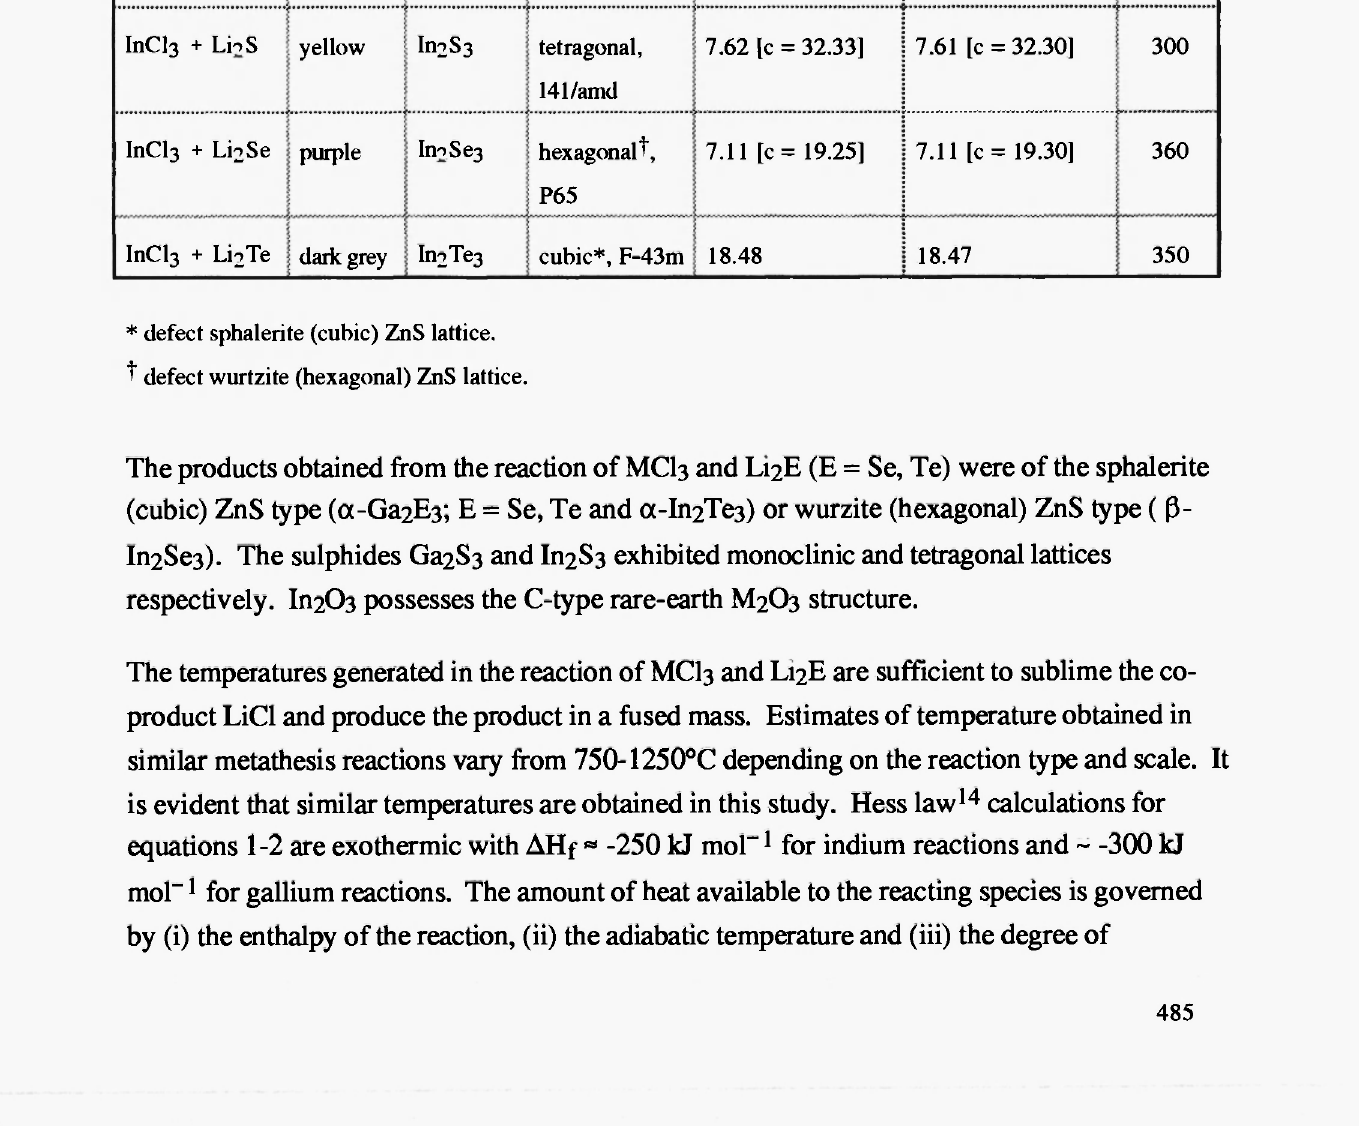
Table., 1. X-ray powder diffraction data from the reaction of MCI3 and L12E. Reagents colour X- phase lattice type/ Literature a Observed a of value/A 1 2 value/A tallite detected space group size/A product by XRD Ga€l3 + Ln.0 white LiGa02 orthorhombic, 5.41 [b = 6.48, c = 5.40 fb = 6.40, c = 320 Pna21 5.011 5.011 GaCl 3 + LioS creani Ga 2 S 3 monoclinic, 11.09 [b = 6.40, c 11.09 [b = 6.40, c 310 = 9.58, β = 141.1°) Cc = 9.57, β = 141.2°] \ GaCl 3 + LioSe red-brown Ga2Se3 cubic*, F-43m j 5.43 5.43 300 1 GaCl3 + Li2Te dark grey Ga 2 Te 3 cubic*, F-43m j 5.90 5.90 360 InCl 3 + LioO white Ιηοθ3 cubic, F-43m 10.12 10.10 320 InCb + LioS yellow In 2 S3 tetragonal, 7.62 lc = 32.33] 7.61 [c = 32.30] 300 141/amd InCl3 + Li2Se purple In->Se3 hexagonalt, 7.11 ]c= 19.25] 7.11 [c = 19.30] 360 P65 InCl 3 + Li 2 Te dark grey In2Te3 cubic*, F-43m 18.48 18.47